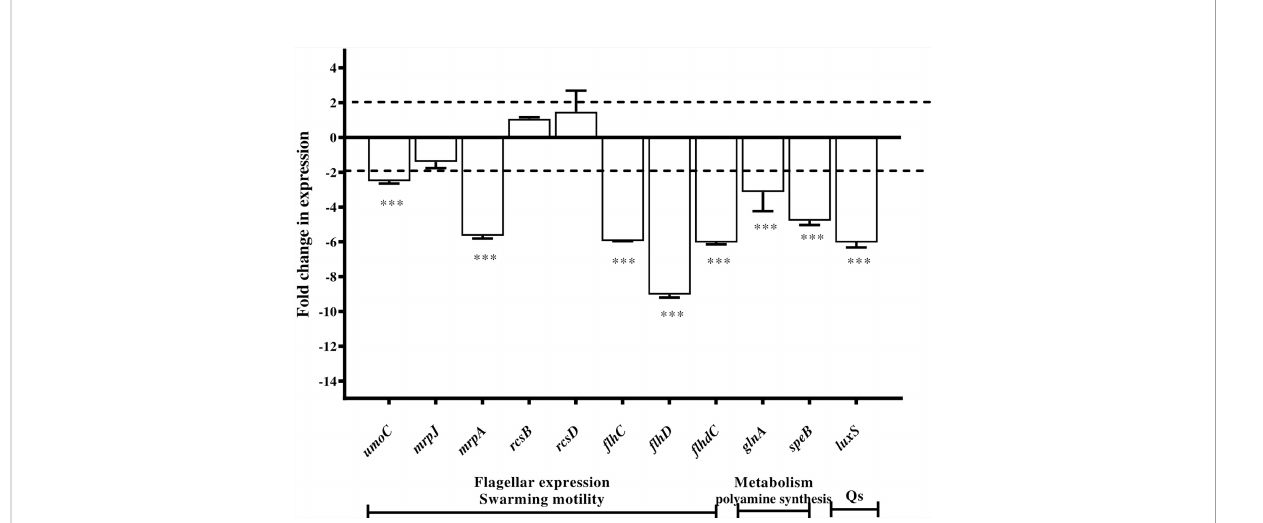
FIGURE 4 Downregulation of Proteus mirabilis virulence genes under the effect of indole extract. Alteration in gene expression pro fi les associated with exposure of P. mirabilis ATCC 12453 in the presence of indole extract Zch127 (sub-MIC 0.6 mg/mL) relative to control as determined by RT- qPCR.Fold change refers to the mean levels of gene expression across replicates, calculated using the DD Ct method relative to the untreated control where fold change = (2 - DD Ct ). Fold change (>1) indicates up-regulation, (<1) indicates down-regulation and fold change (~1) means insigni fi cant change. Swarming activity genes ( umoC, fl hC, fl hD, fl hDC and mrpA ), polyamaine synthesis genes ( speB and glnA ) and quorum sensing gene ( luxS ), while regulatory genes ( mrpJ, rcsB and rcsD ). The data is representative of three independent experiments as means and error bars show standard deviation. Statistical analysis using two- way ANOVA with p ≤ 0.05 is considered statistically signi fi cant and ***P < 0.001 compared with DMSO